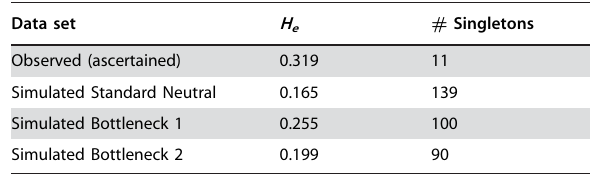
Table 6. Properties of data sets simulating full resequencing. ... ... .... ... ... .... ... ... .... ... ... .... ... ... .... ... ... .... ... ...